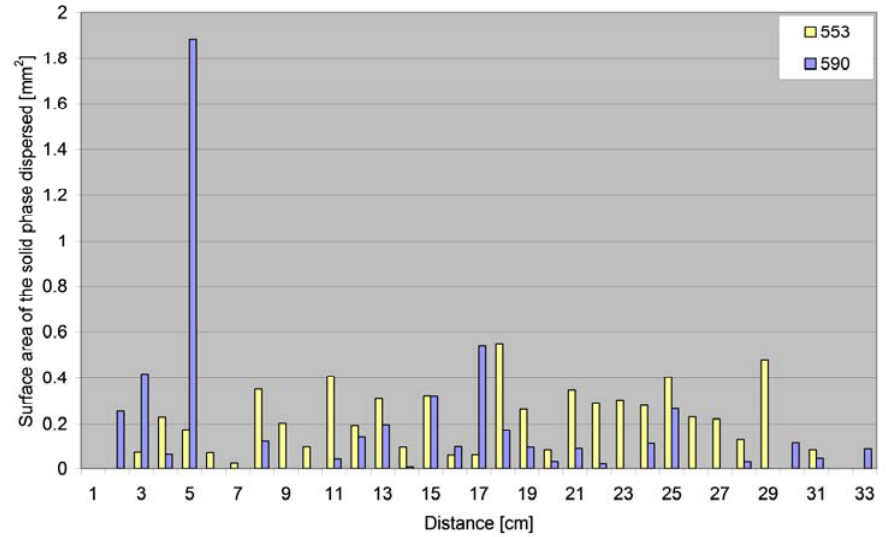
Figure 11. The surface areas of the solid phase dispersed at a given distance (distances rounded to the nearest